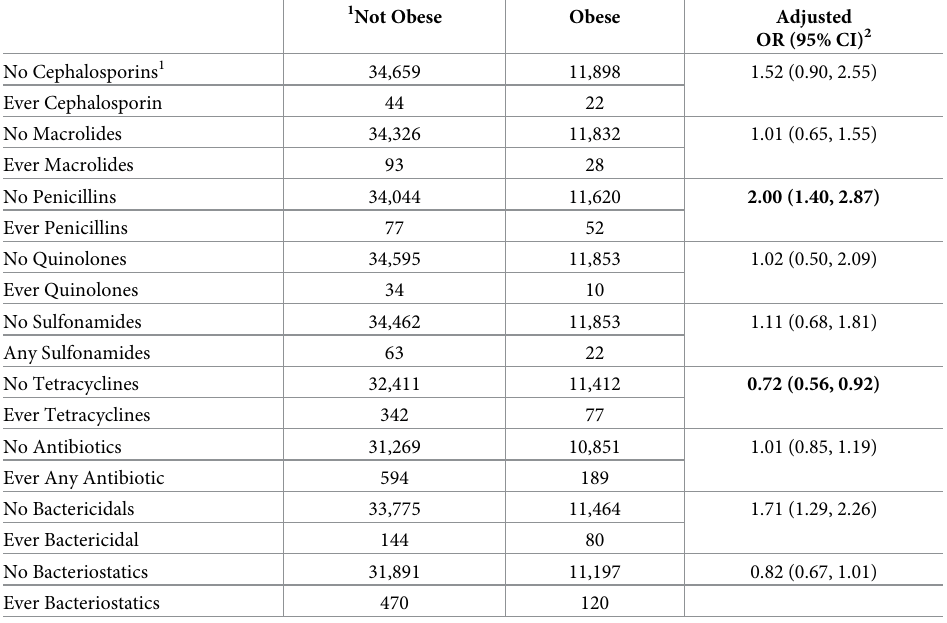
Table 3. Incidence odds ratios of associations for initiating antibiotic use during the 4 th decade of life with obesity at enrollment. 1 Not